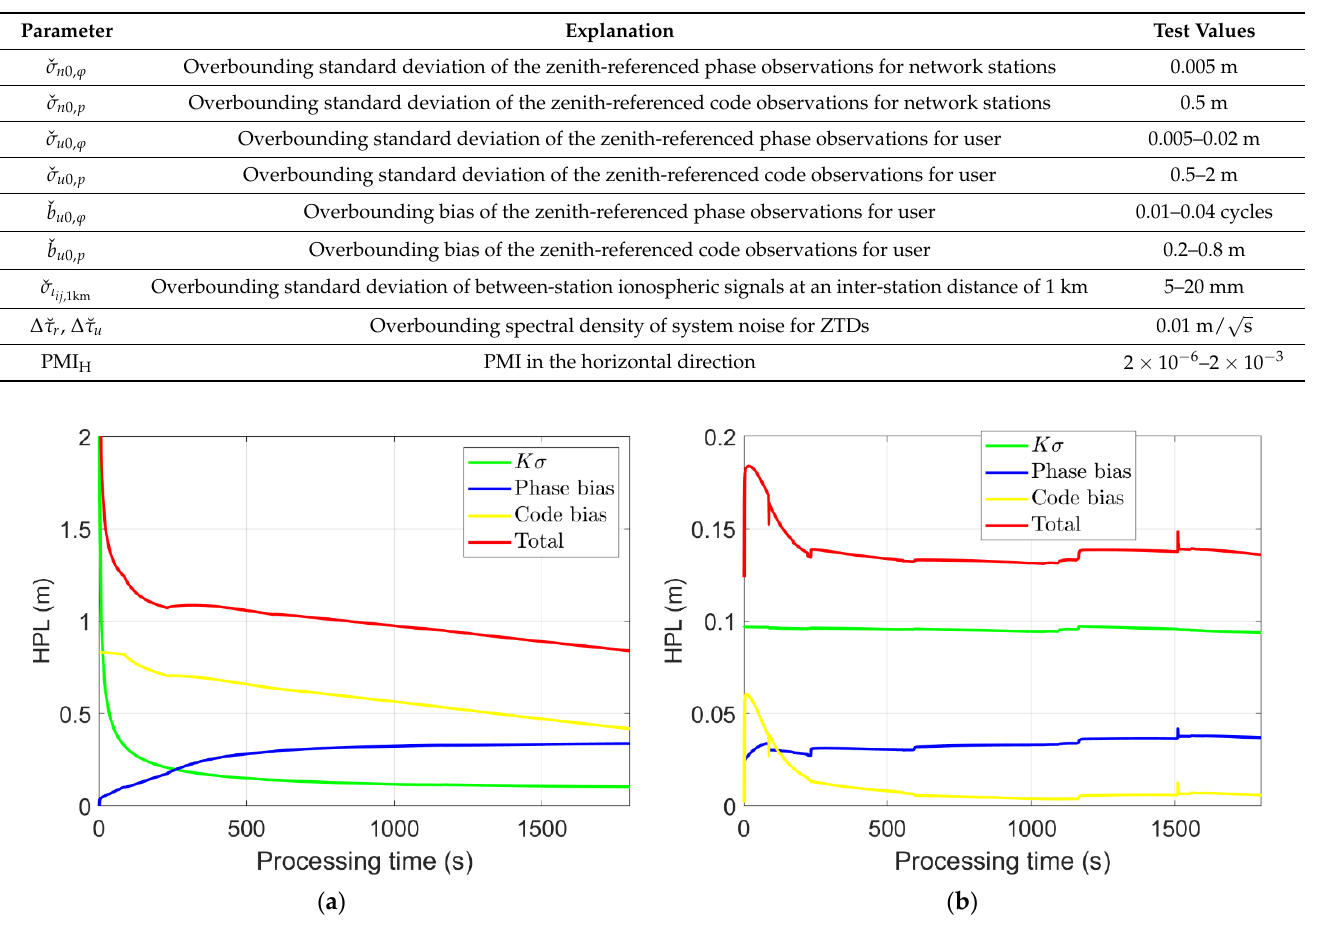
Figure 8. HPL contributions of different factors in: ( a ) the ambiguity-float case; ( b ) the ambiguity- fixed case under nominal conditions for the worst-location user in Network 1.